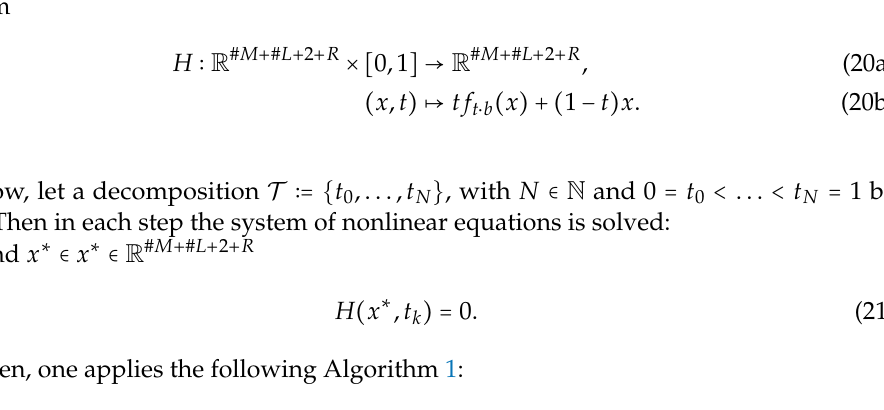
Algorithm 1: Homotopy